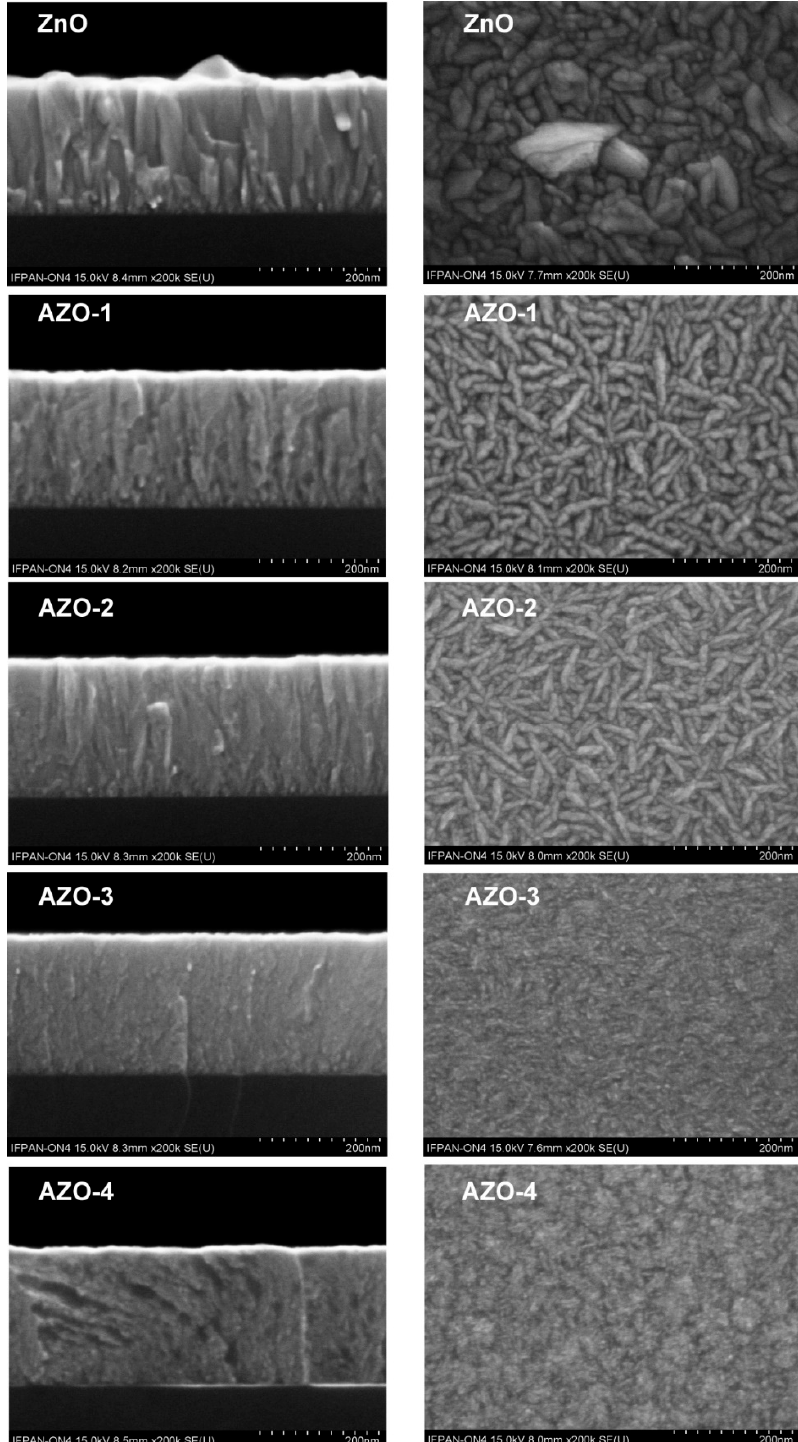
Figure 2. The SEM images of cross section ( left column ) and top view ( right column ) of ZnO and AZO layers on Si substrates.